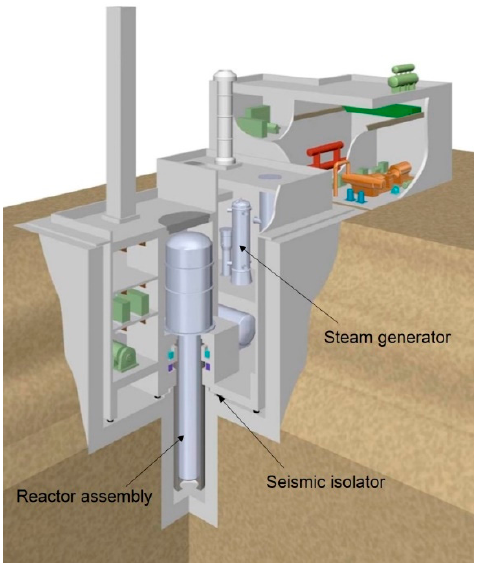
Figure 6. Cutaway drawing of a 4S plant.